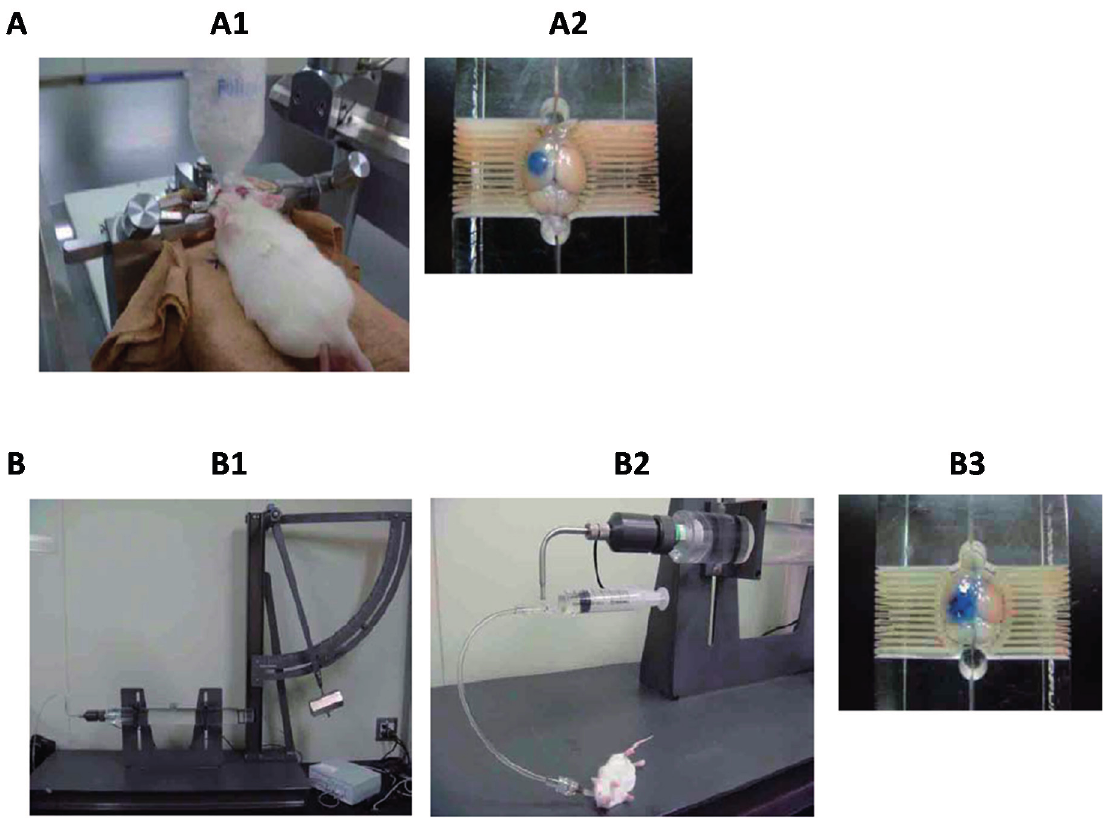
Figure 2. Brain edema model in experimental animals. ( A ) Cold injury is performed by inflicting freeze stimulation on the hemisphere of the skull of the animal ( A1 ). After cold injury, BBB disruption is indicated by evaluating extravasation of Evans blue dye ( A2 ); ( B ) Fluid percussion injury is performed by an injury to the intact dura after craniectomy by impacts of rapidly pushed fluid ( B1 , B2 ). As well as cold injury, the extravasation of Evans blue dye is observed ( B3